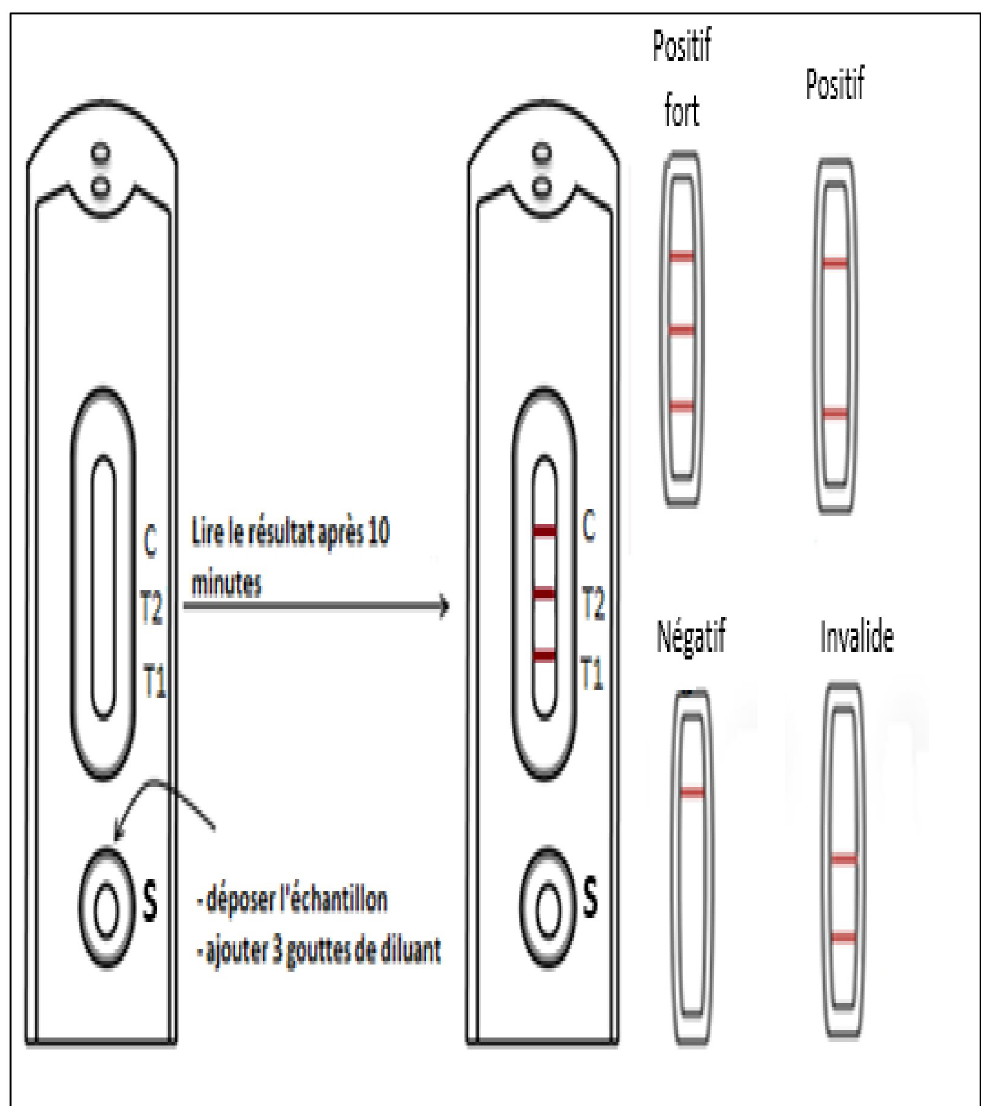
Fig 1. Interpretation of the results of Cryptops 1 test. Cryptococcal antigen carriage among children aged 6 months to 15 years infected with HIV at Laquintinie Hospital in Douala.